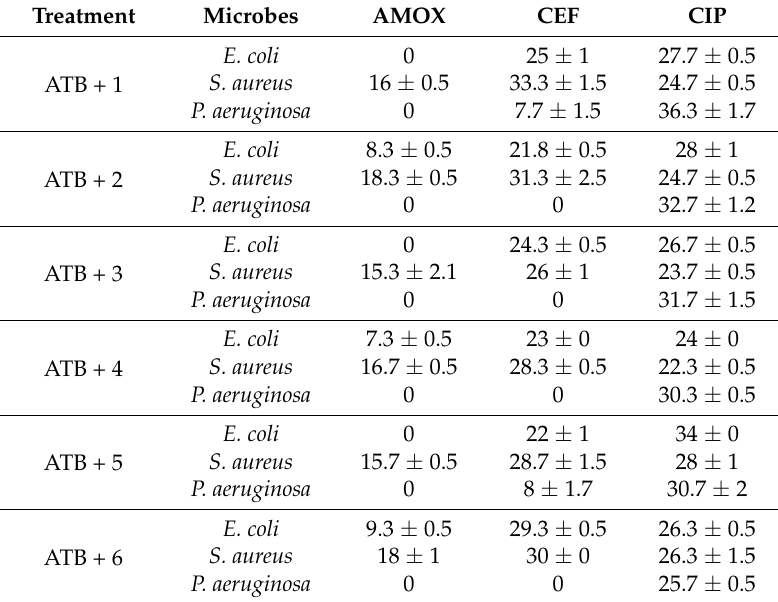
Table 2. Zone of inhibition, mm as an effect of different antibiotics (Amoxicillin (AMOX), Cefuroxime (CEF) and Ciprofloxacin (CIP)) in combination with AgNPs at MIC (50 mg/L) against Escherichia coli , Staphylococcus aureus and Pseudomonas aeruginosa